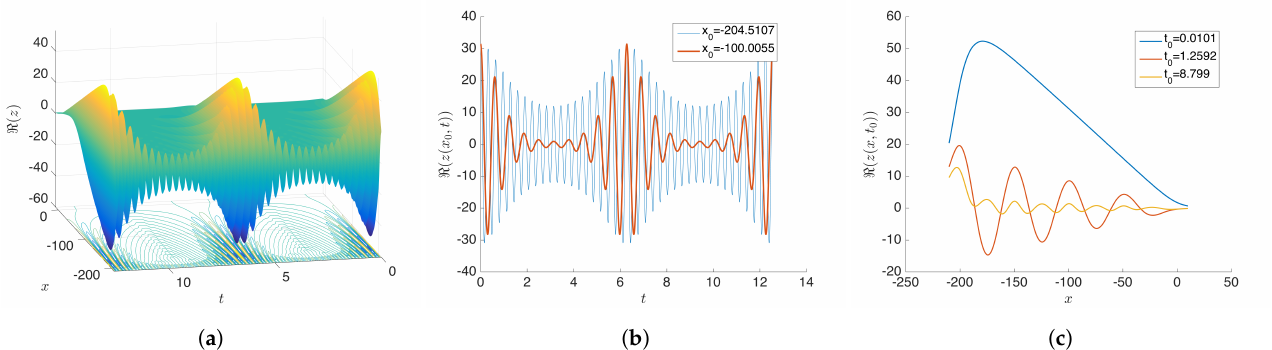
Figure 7. Original dataset constructed by Equation (15). ( a ) shows the Re ( z ( x , t )) plot for all x , t values at 20,000 × 5000 grid points. ( b ) represents the time series plot for two initial conditions. ( c ) provides the snapshots of few different time points. Our goal is separate and isolate spatial variables Φ j ( x ) = j sech ( 0.1 x + j ) and T j ( t ) = e ijt from the given data constructed by z ( x , t ) .